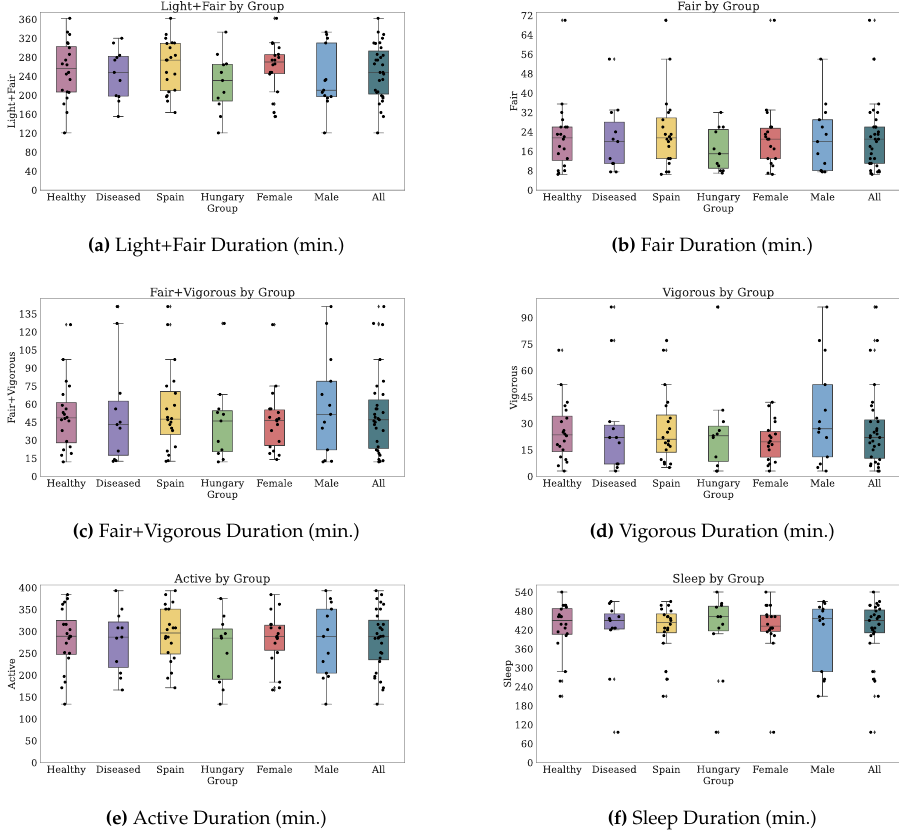
Figure A17. Median values of TechROs (Fitbit) across the entire monitoring period: light+fair duration, fair duration, fair+vigorous duration, vigorous duration, active duration, sleep duration (2 of 2)